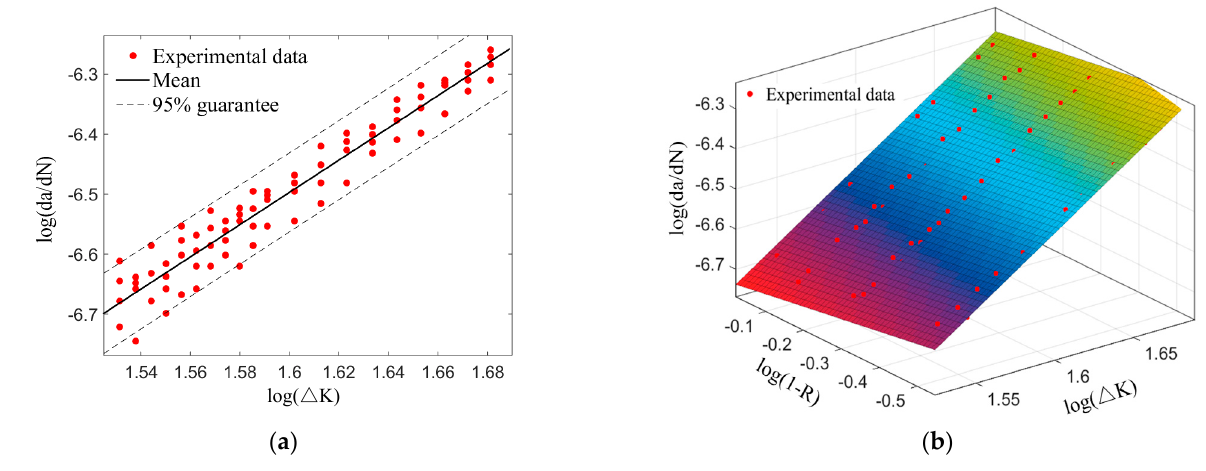
Figure 6. Experimental data fitting of steel Q345qD. ( a ) Paris; ( b ) Walker and da/dN −Δ G − R. Table 3. Material parameters of steel Q345qD.